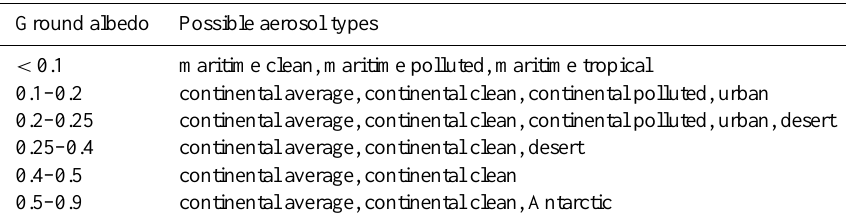
Table 5. Empirical allocation of aerosol types according to ground albedo.